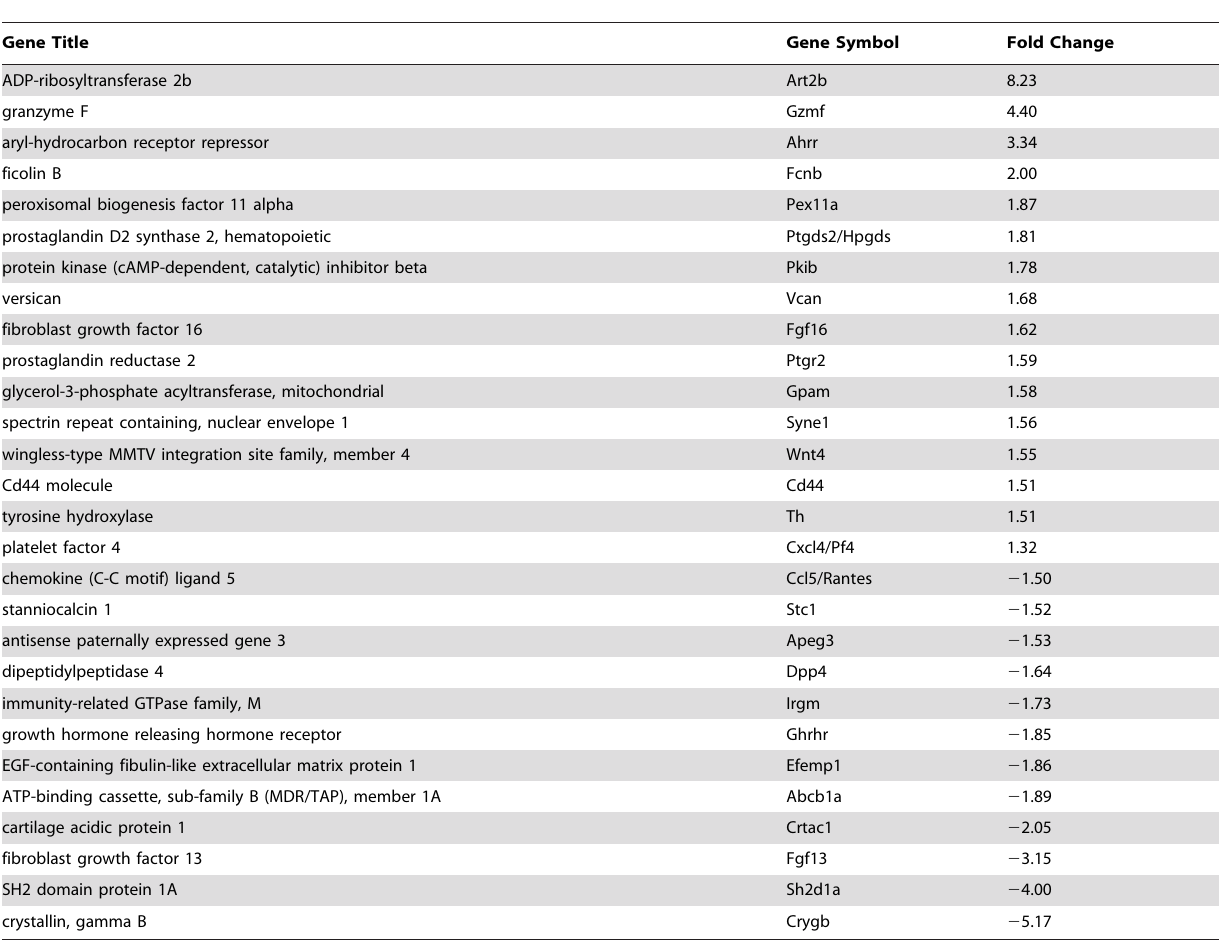
Table 2. Sub-list of relevant genes TCDD-regulated in